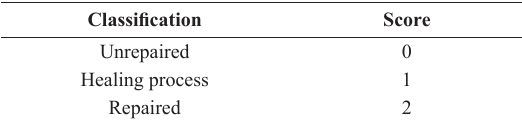
Table 2. Classification of the tissue repair pattern in relation to the epithelial